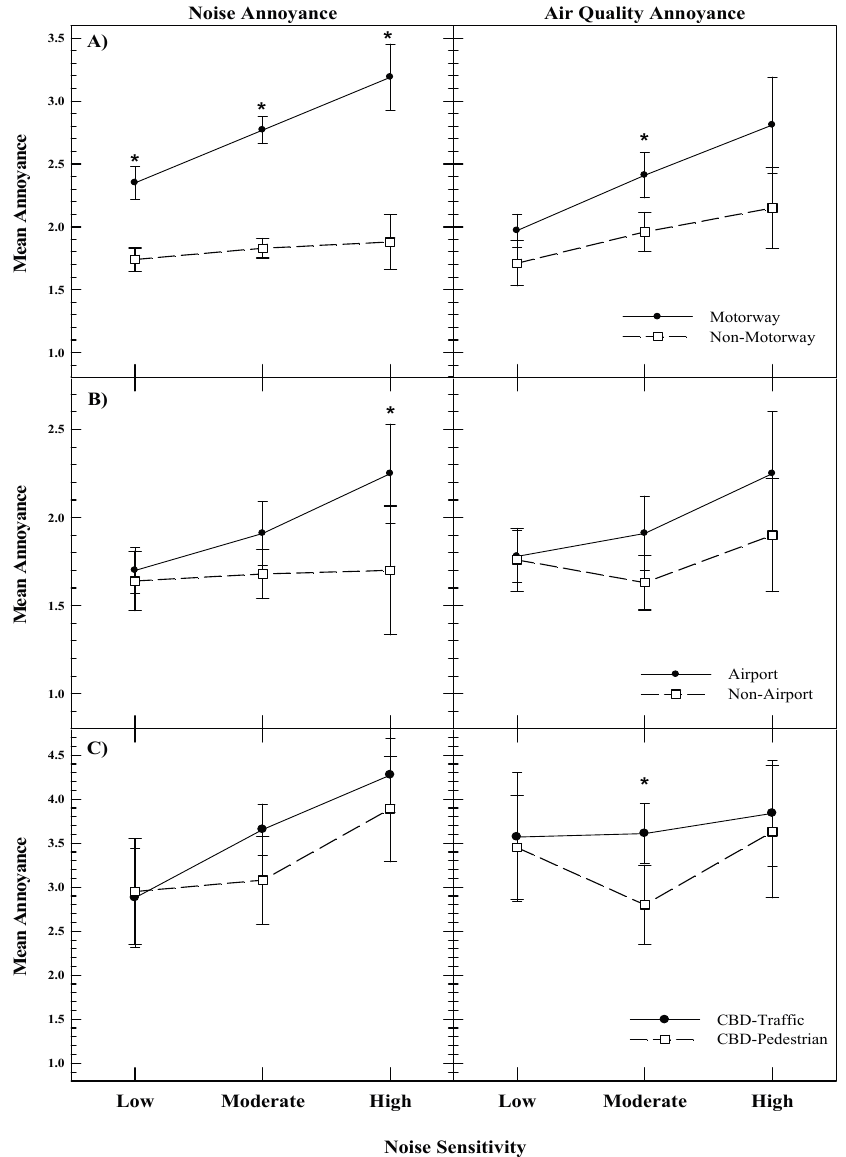
Figure 1. Mean annoyance to noise and air pollution as a function of self-reported noise sensitivity for samples collected in two New Zealand cities: Auckland (top and bottom panels) and Wellington (middle panel). Whiskers are 95% confidence intervals, with asterisks indicating significant differences between means ( p < 0.05). Note the different scales on the y